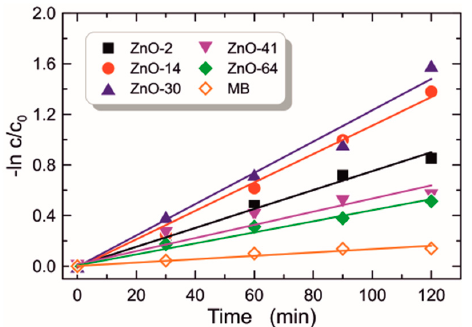
Figure 13. Plots of − ln( c / c 0 ) as a function of reaction time for the degradation of MB dye without (orange empty diamonds) and with the presence of the catalyst.